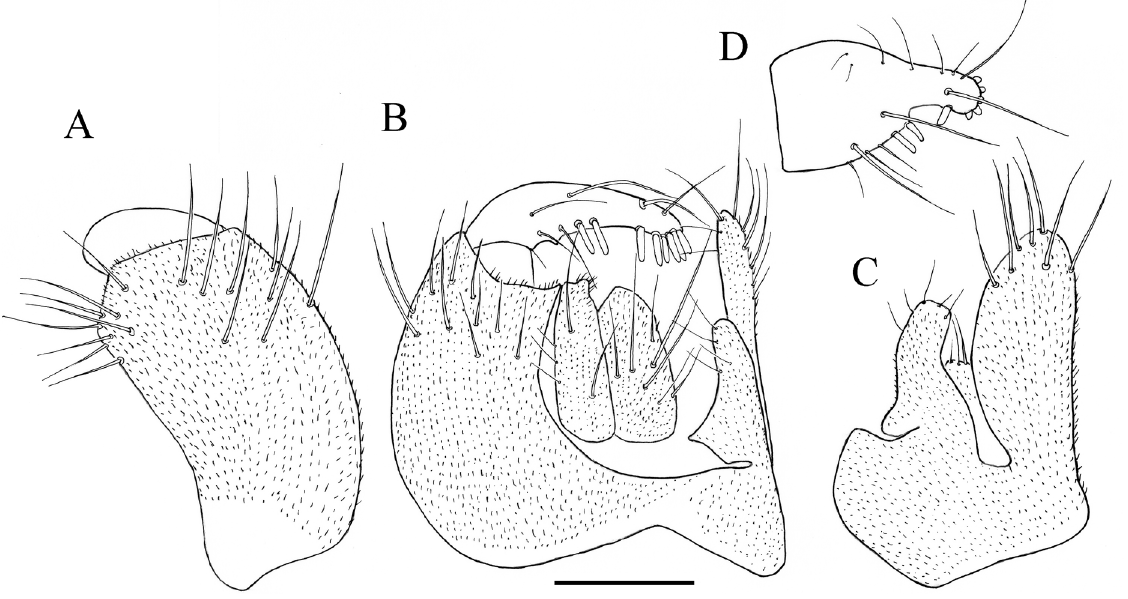
lamella and left surstylus. D . Right surstylus. Scale bar: